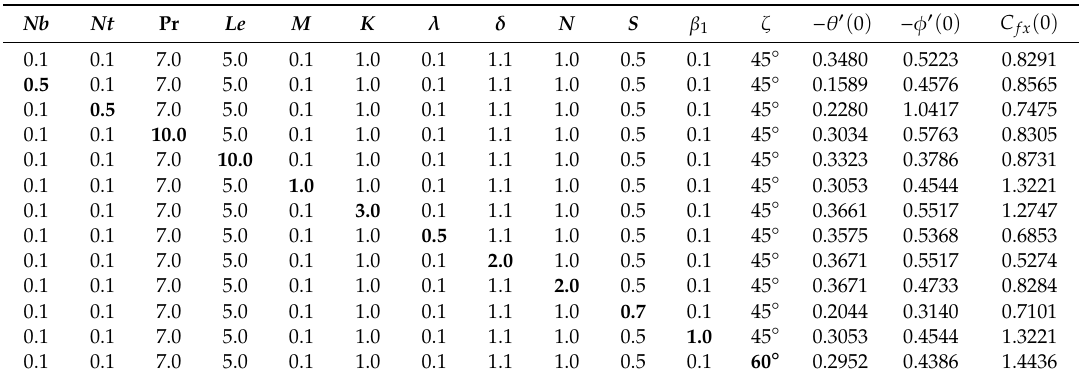
Table 2. Values of − θ (cid:48) ( 0 ) , − φ (cid:48) ( 0 ) , and C fx ( 0 ) . The bold data shows the variation in that parameter while others are kept